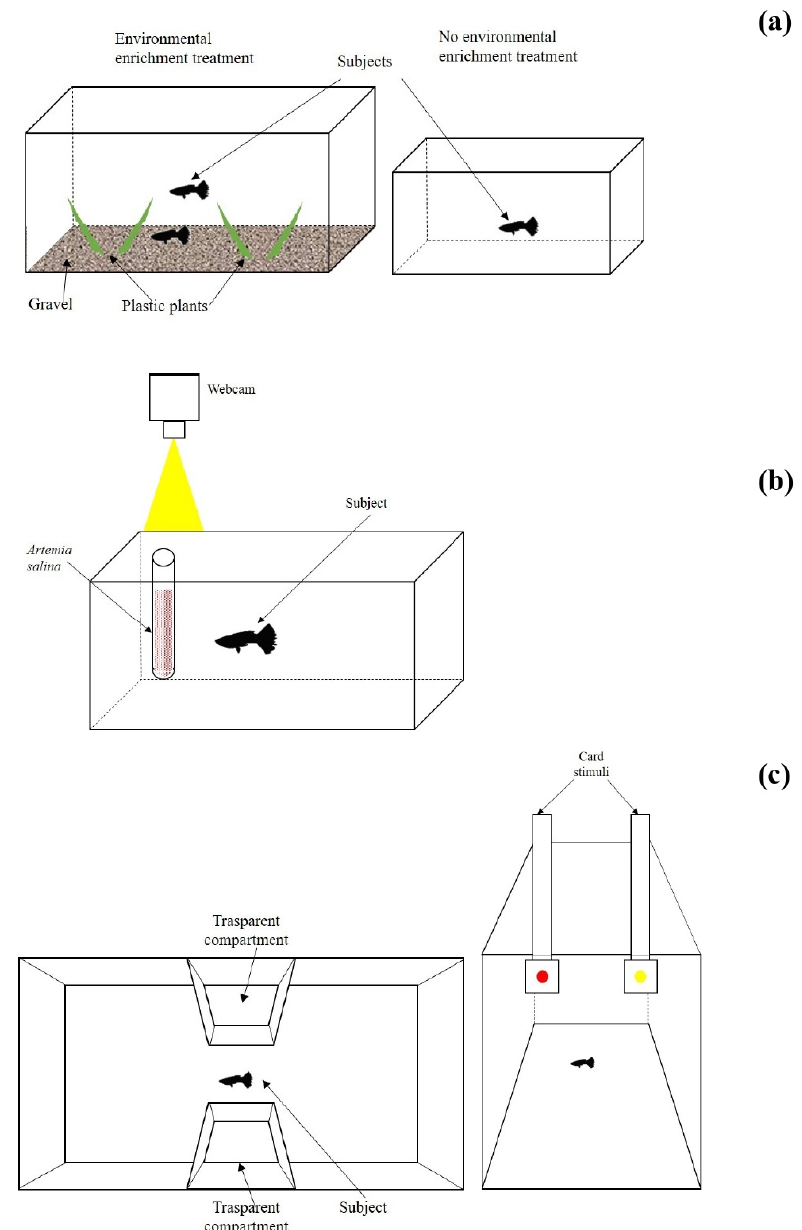
Figure 1. ( a ) Scheme of the aquaria used in the two treatments: the guppies of the enriched treatment (left) were housed in a 6-L aquarium with gravel bottom, plastic plants, and a conspecific, and they were fed with live A. salina ; the guppies of the treatment with no enrichment were housed individually in a 2-L barren tank and fed with frozen A. salina (right). ( b ) Apparatus used in the inhibitory control task: the guppies were tested individually with a prey hidden inside a transparent tube. ( c ) Apparatus used in the learning task and in the cognitive flexibility task; the subjects were tested individually in the choice between two stimuli with different color, with a reward associated to the approach of the correct color.